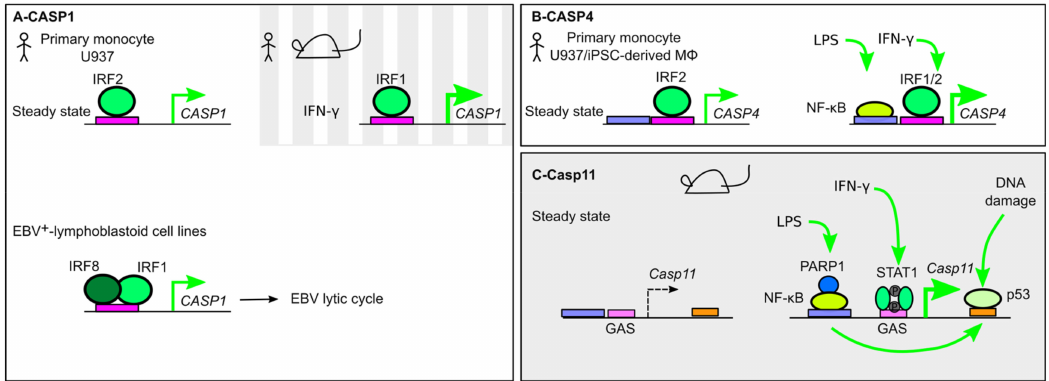
Figure 3. Transcriptional regulation of inflammatory caspases. ( A ) In human monocytes, CASP1 expression is regulated at steady state by IRF2, while in the presence of IFN- γ , IRF1 regulates its expression. In Epstein–Barr virus (EBV + ) lymphoblastoid cell lines, a ternary IRF1 / 8 / DNA complex controls CASP1 expression and EBV lytic cycle. ( B ) CASP4 is constitutively expressed in human monocytes in an IRF2-dependent manner. IFN- γ and lipopolysaccharide (LPS) can upregulate CASP4 expression by promoting NF- κ B and IRF1 binding to the CASP4 promoter. ( C ) Casp11 expression is undetectable at steady state but demonstrates a strong upregulation in the presence of LPS or IFN- γ , a positive cofactor of NF- κ B. DNA-damage triggers p53 binding in the Casp11 first intron and